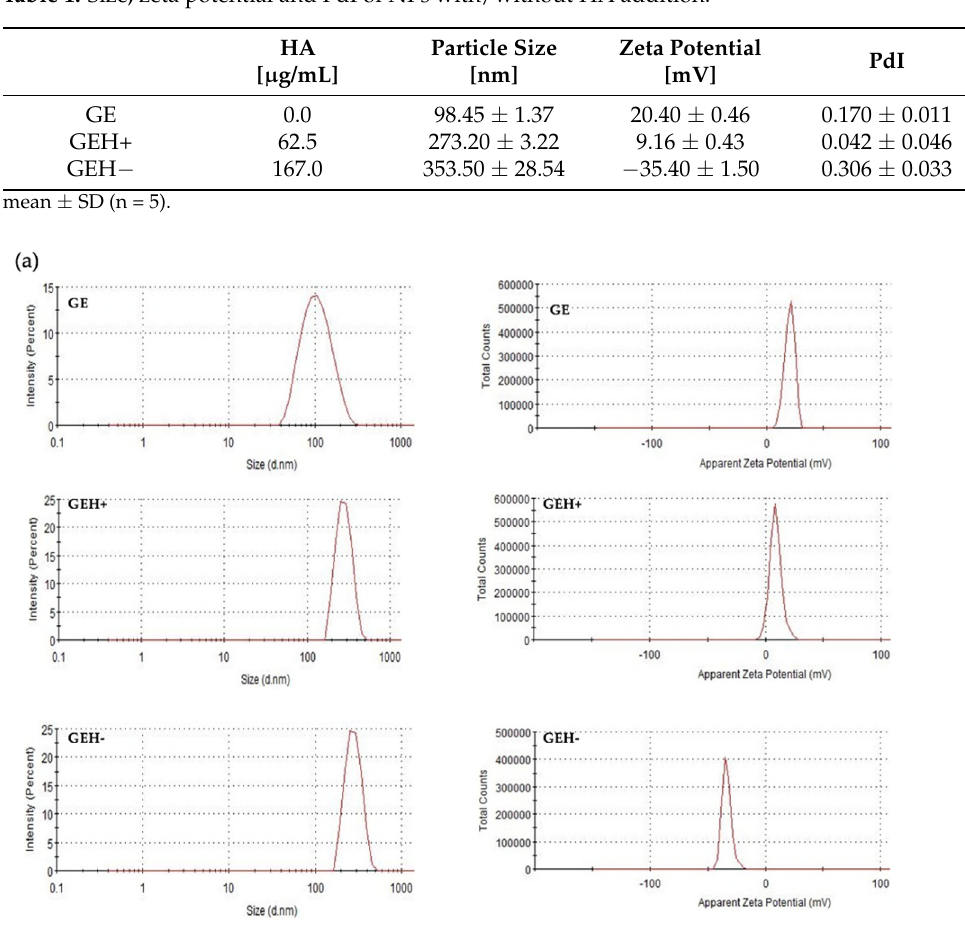
Table 1. Size, zeta potential and PdI of NPs with/without HA addition.